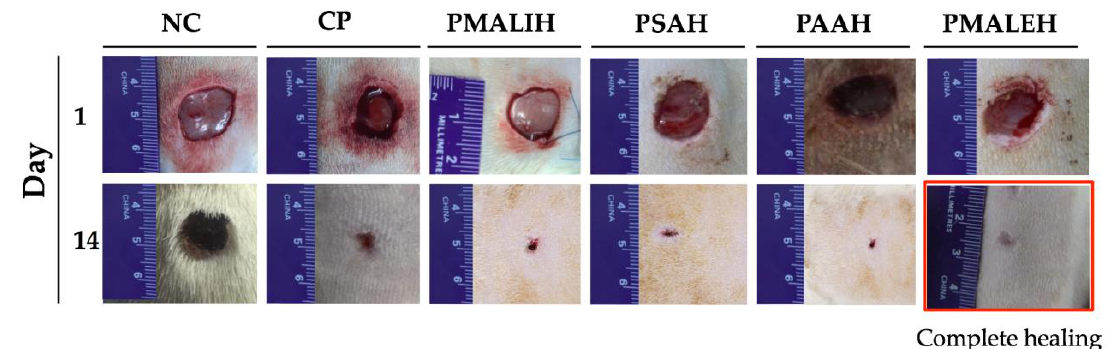
Figure 5. In vivo assessments of the film dressings for wound healing. NC: PSAH (Negative control, film dressing without BC); CP: Madecassol ™ (Commercial Product); PMALEH, PSAH, PAAH and PMALIH as proposed film